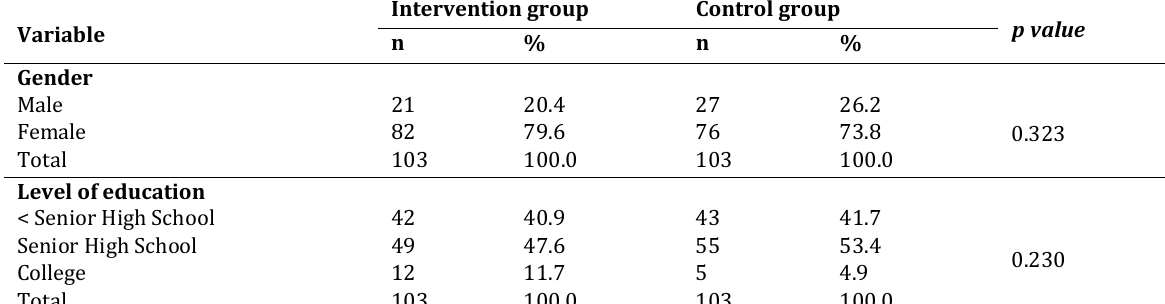
Table 3. Parents/Guardians of the Students by Income and the Relationship with the Children in both the Intervention and Control Group (n = 206) Variable